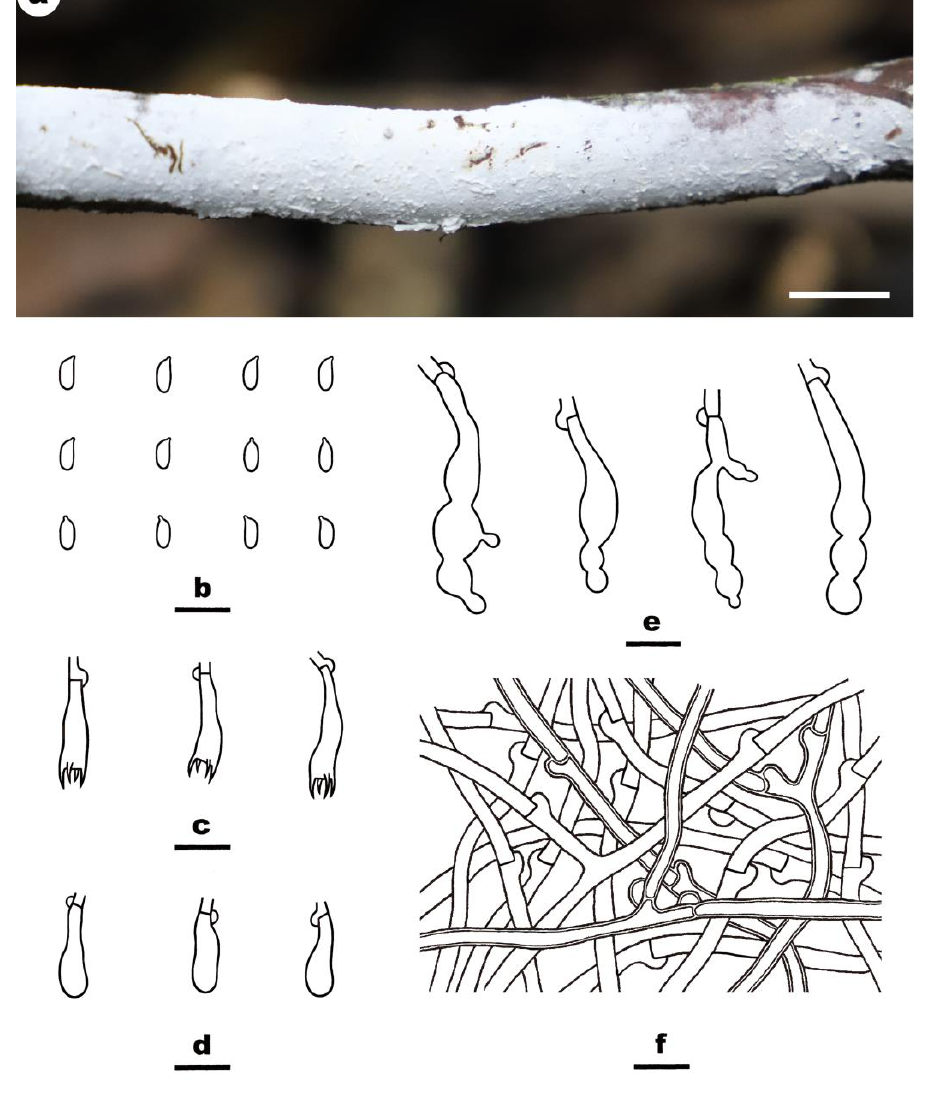
Figure 4 MycoBank: MB844199